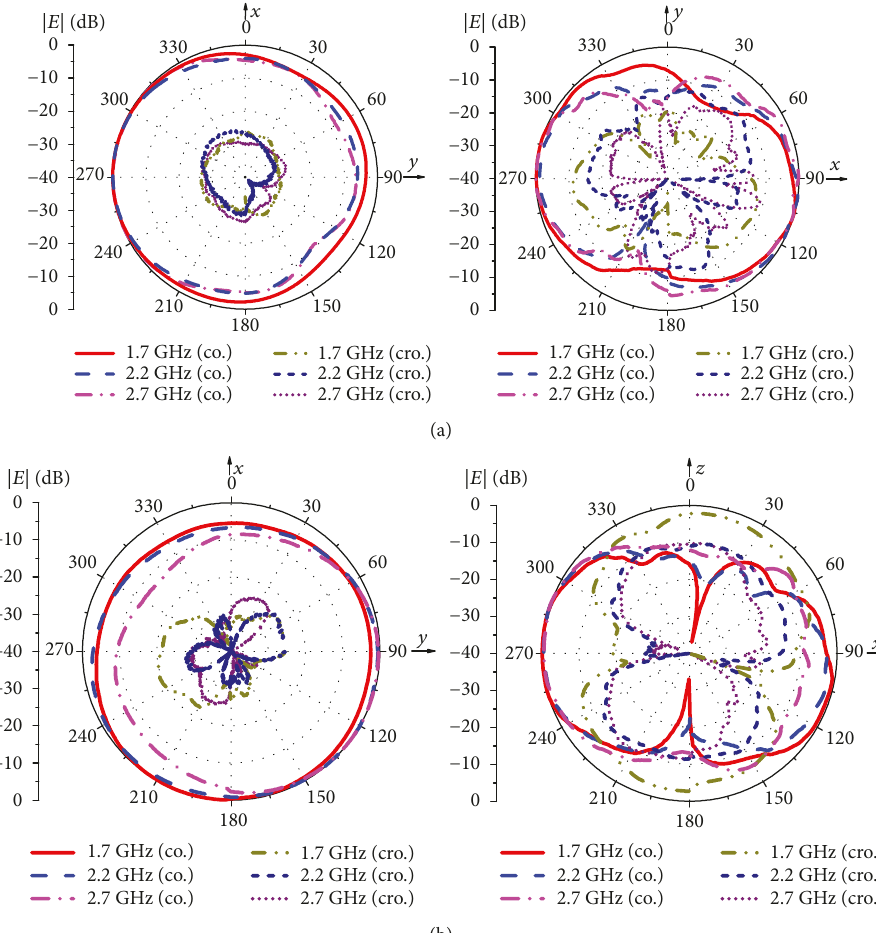
Figure 13: Measured radiation patterns of the wideband DP quasi-omnidirectional antenna: (a) port 1 for HP and (b) port 2 for VP.